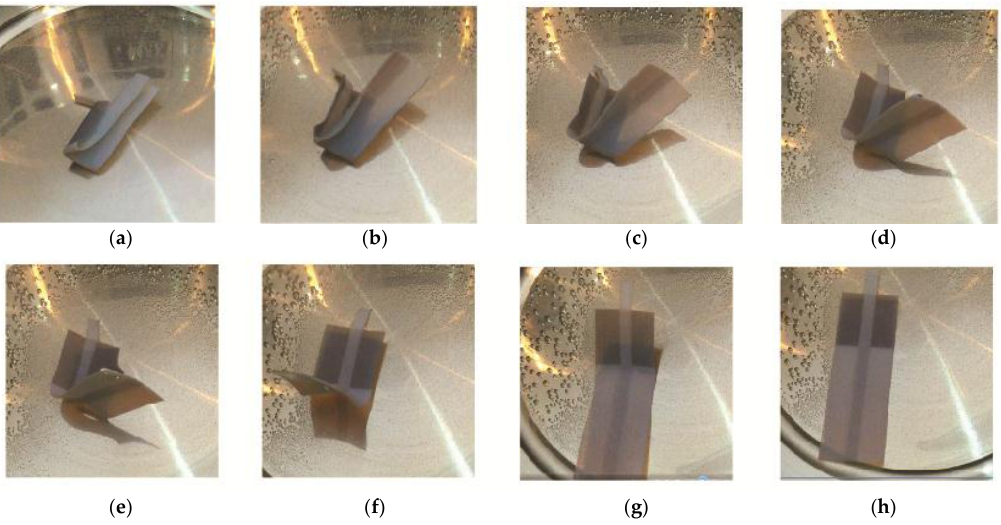
Figure 36. Method 1—the sequence of unfolding from ( a ) Folded specimen ( b ) DM8530 (dark grey) unfolding ( c – e ) Unfolding of DM8520 along folding line 2 ( f ) DM8510 unfolding ( g ) VeroWhitePlus unfolding ( h ) Specimen fully unfolded.